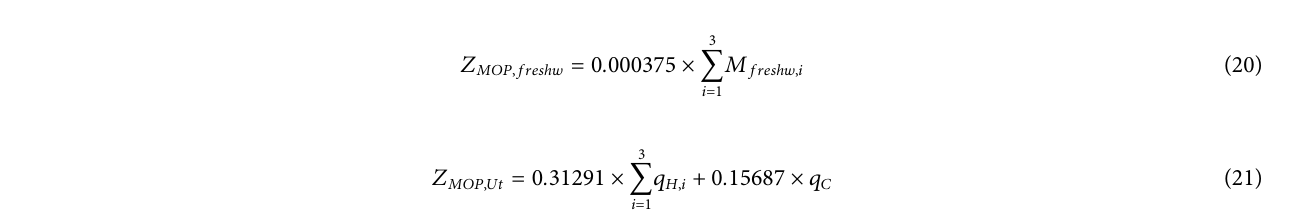
TABLE 14 | Objective-functions of the MOP model optimisation problem.